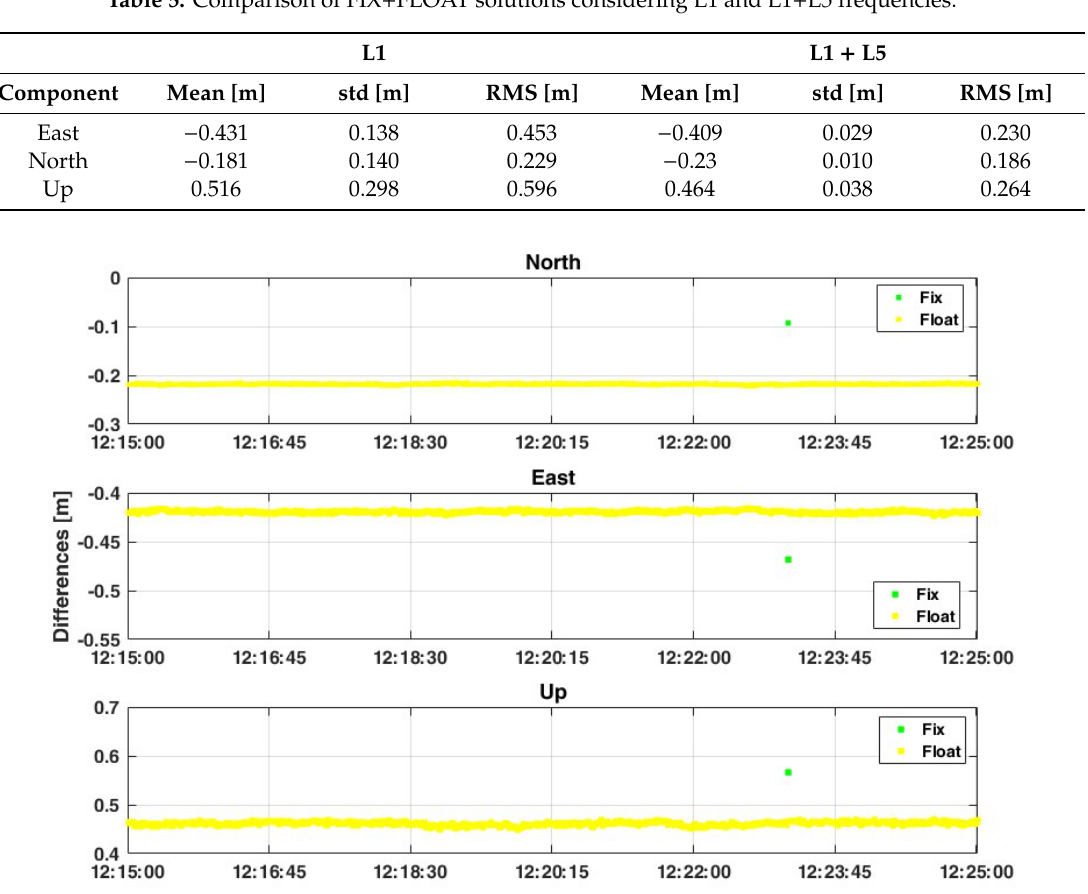
Table 4. Comparison between FIX+FLOAT solutions with the FLOAT-only ones, if the L1 frequency is considered.